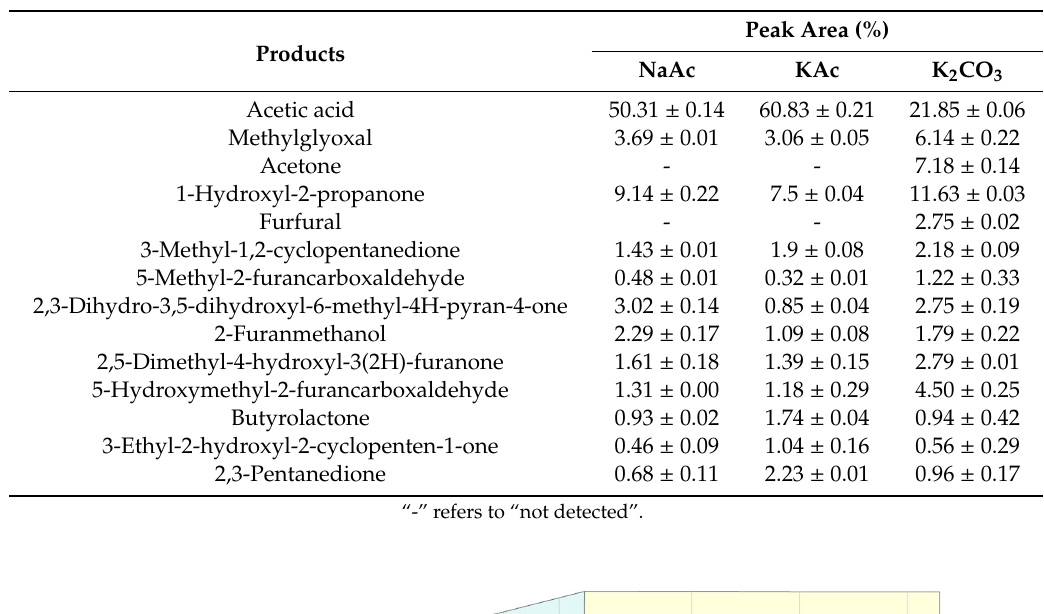
Table 6. Typical products distributions obtained from the glucose in situ catalytic pyrolysis over KAc, NaAc or K 2 CO 3 at 350 ◦ C for 30 s.